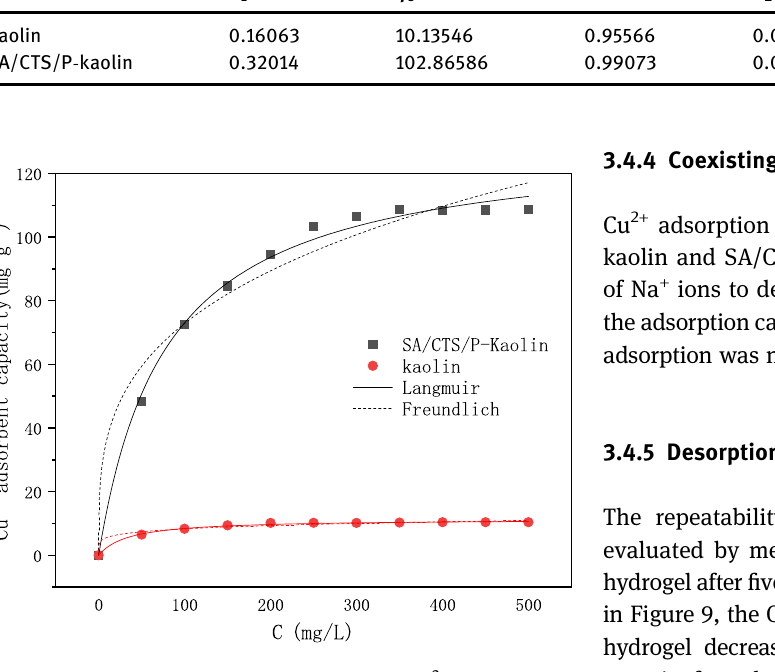
Figure 7: Langmuir and Freundlich isotherms of Cu 2 + removal by SA/CTS/P - kaolin and kaolin adsorbents.